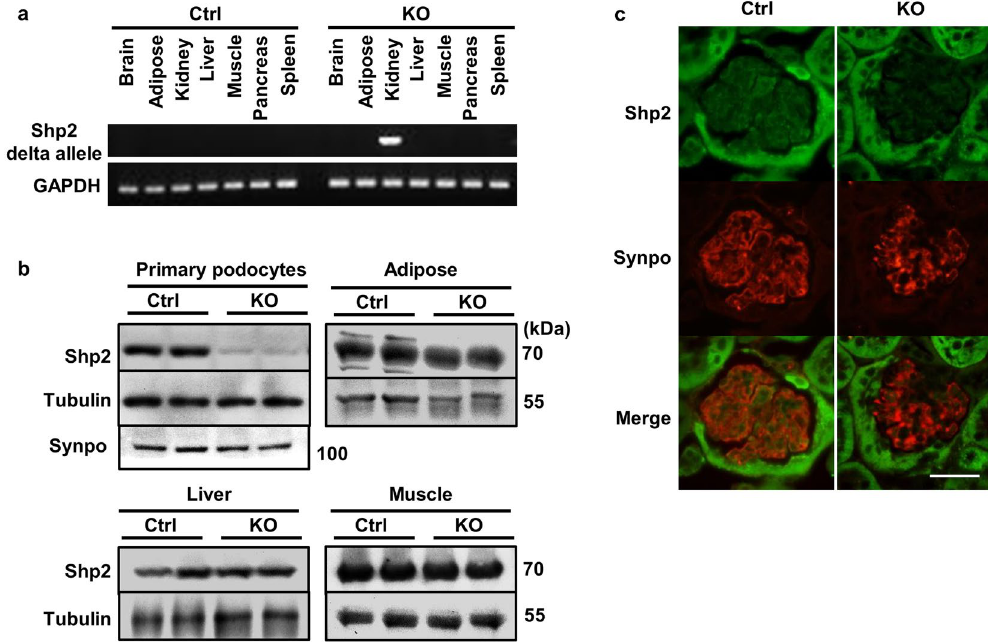
Figure 2. Efficient and specific deletion of Shp2 in podocytes. ( a ) Genomic DNA was extracted from tissues (as indicated) of control (Ctrl) and pod-Shp2 knockout (KO) mice. Deletion of the floxed allele was detected by PCR, and GAPDH served as a loading control. ( b ) Immunoblots of Shp2 protein expression in isolated primary podocytes, adipose (epididymal fat), liver and muscle from Ctrl and KO mice. Tubulin and synaptopodin (Synpo, for podocytes) presented as loading controls. ( c ) Immunostaining of Shp2 (green) and synaptopodin (red) in kidney sections from Ctrl and KO mice. Scale bar: 50 µ